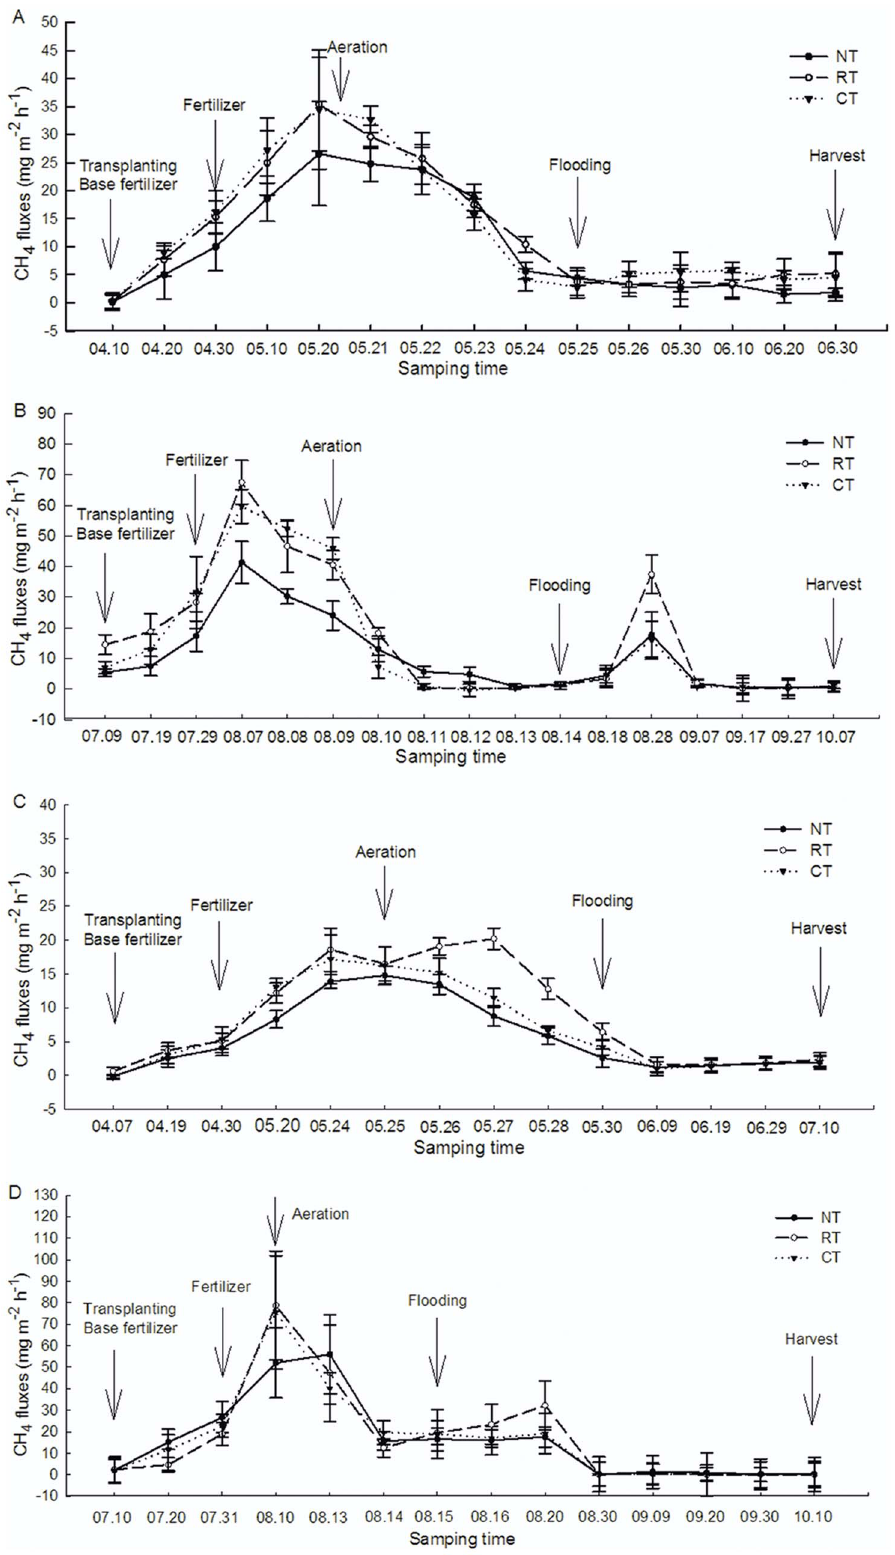
Figure 3. CH 4 flux under different tillage during the rice growing seasons (A, B for the early rice season and the late rice season in 2007; C, D for the early rice season and the late rice season in 2008, respectively). Vertical bars represent standard errors of the mean (n=3).The arrows in the figures indicate the time of field operation.